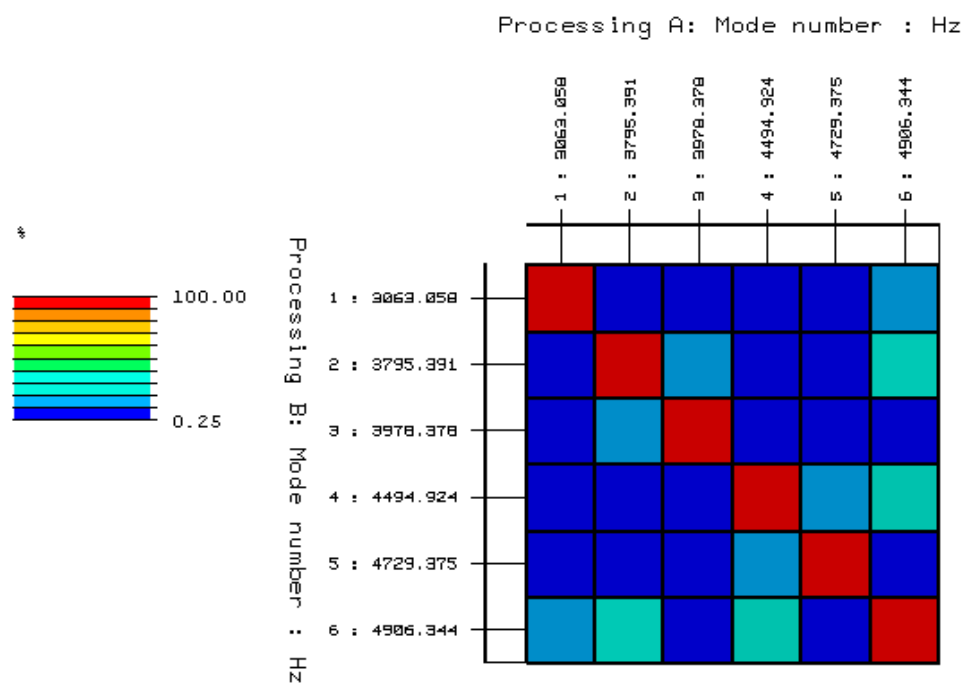
Figure 14. Validation of the selected stable poles and the corresponding modes of free vibration using the AutoMAC function. Table 3. The result of the validation (AutoMAC) in tabular form for the damaged full ceramic brick. Damaged